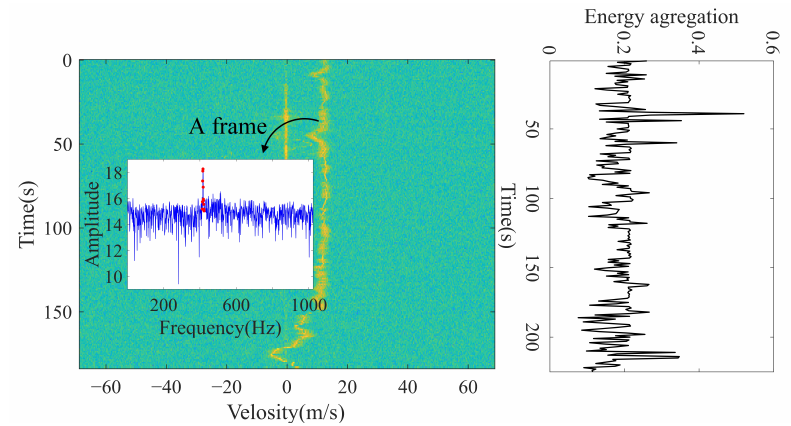
Figure 5. Energy aggregation feature extraction process demonstration. Feature8: energy aggregation mean feature F 31 .